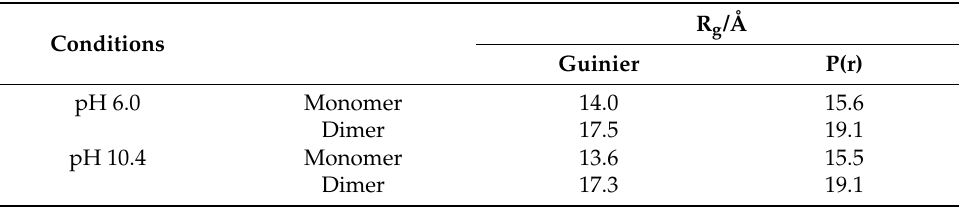
Table 2. Simulated R g values calculated from the crystal structures at pH 6.0 (PDB 4WGZ) and 10.4 (PDB 4WGY).